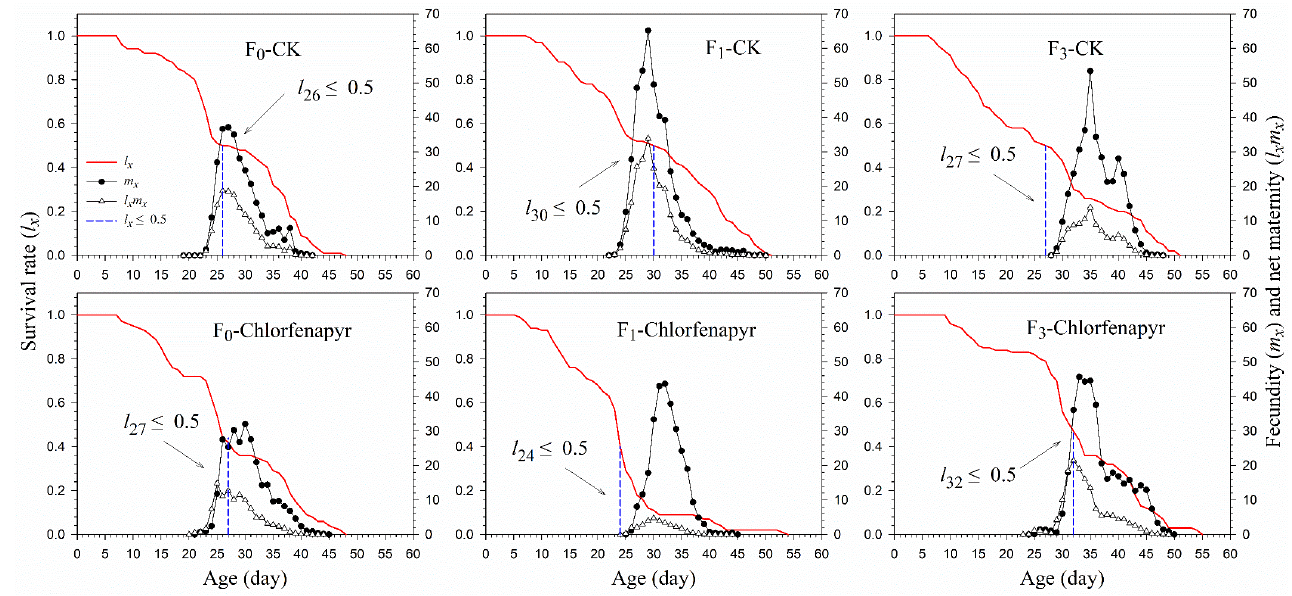
Figure 2. Survival rate ( l x ), fecundity ( m x ), and net maternity ( l x m x ) of P . marginatus (F 0 , F 1 , and F 3 ) exposed to LC 30 dose of chlorfenapyr. CK represents the control.